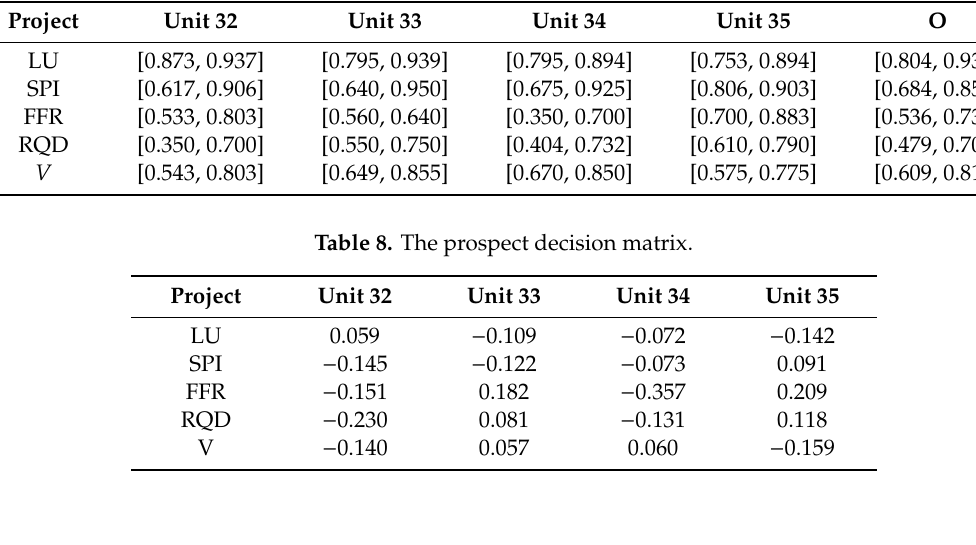
Table 7. The scoring function matrix.